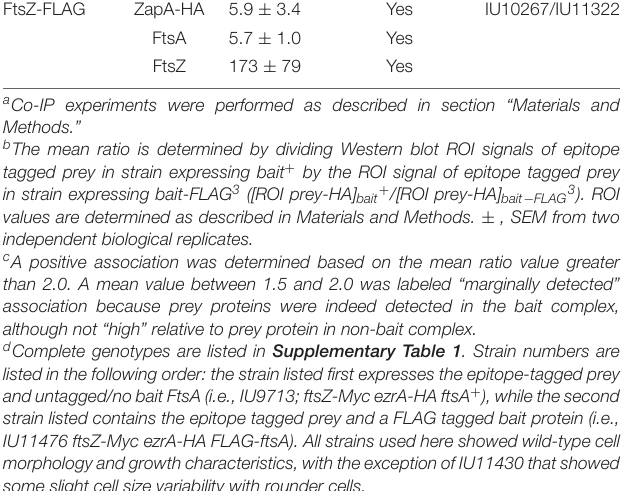
complex between EzrA and aPBP2a or bPBP2b ( Supplementary Figure 22C ; Table 2 ). Consistent with the co-IP data, B2H assays detected interactions between EzrA and aPBP1a or bPBP2x and a lack of detection with bPBP2b, although an interaction with aPBP2a was detected using B2H ( Supplementary Figure 21